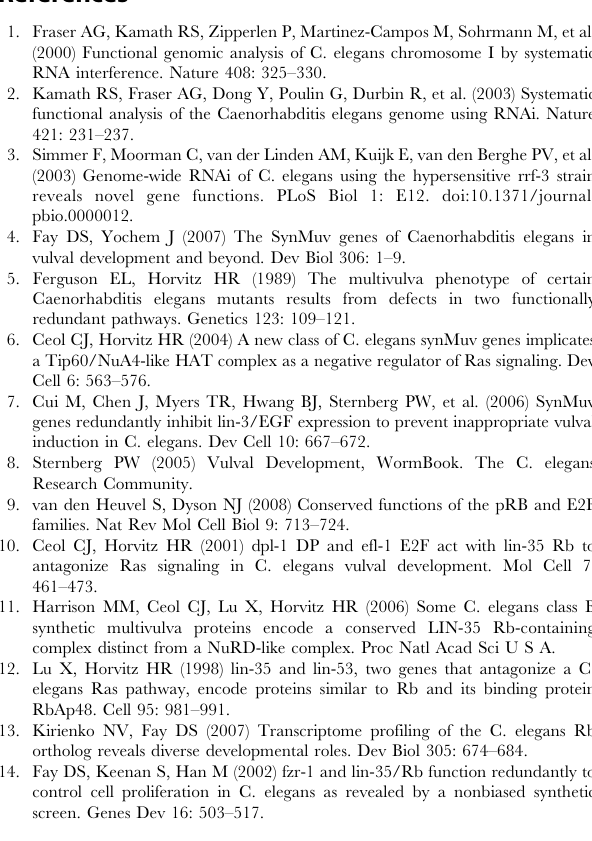
Figure S1 Quantification of PHA-1::GFP (A and B) and P pha- 1 ::GFP (C and D) fluorescence intensities in individual embryos in N2 (A and C) and sup-35 ( tm1810 ) mutant backgrounds (B and D). Found at: doi:10.1371/journal.pgen.1000510.s001 (0.20 MB TIF) Figure S2 Quantification of SUP-35::GFP fluorescence intensi- ties in individual embryos following treatment of strains with vector RNAi (A), lin-35(RNAi) (B), ubc-18(RNAi) (C), and ari- 1(RNAi) (D). Found at: doi:10.1371/journal.pgen.1000510.s002 (0.23 MB